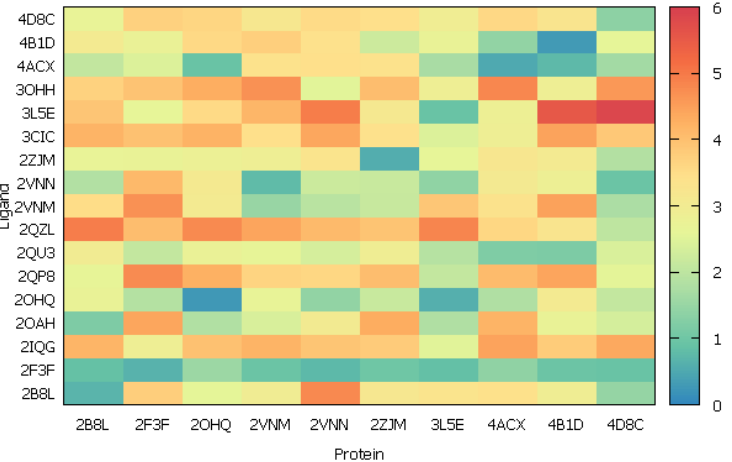
Figure 3. Matrix plot for RMSD analysis of ligand poses upon